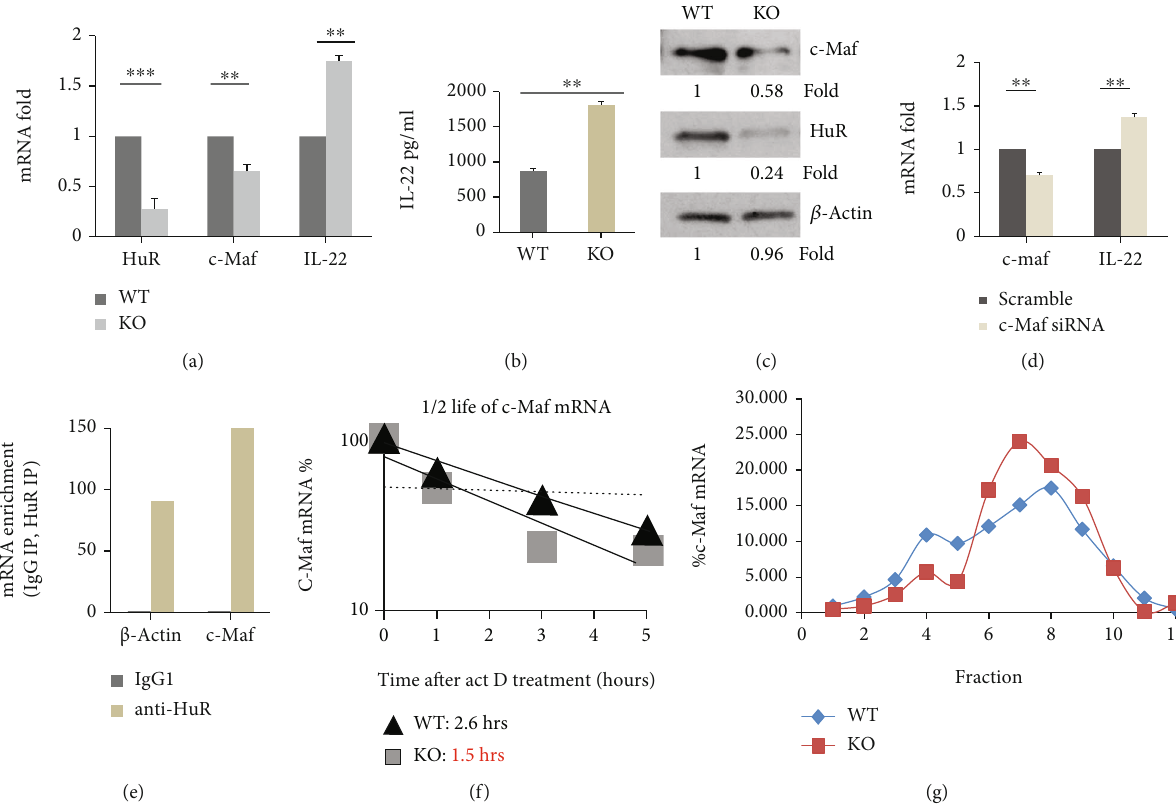
Figure 5: HuR de fi ciency increases IL-22 production in Th17 cells by reducing c-Maf expression. Naïve CD4 + T cells from WT and HuR KO mice were cultured under Th17 cell polarization condition for 5 days. (a) The expression of c-Maf and IL-22 mRNAs was examined by RT- qPCR. IL-22 mRNA RT-qPCR is a positive control in (a). (b) The levels of IL-22 in WT and HuR KO Th17 cell culture supernatant were examined by ELISA. (c) The abundance of c-Maf and HuR protein in WT and HuR KO Th17 cells was examined by western blots. (d) Naive WT CD4 + T cells were transduced with c-Maf siRNA and scramble siRNA and polarized under Th17 cell culture condition for 5 days. The expression of IL-22 and c-Maf mRNA was measured by RT-qPCR assay. (e) HuR bound to c-Maf mRNA as determined by RIP assay; one of the two repeated experiments is shown. The repeated RIP experiment got the same tendency of results. (f) Actinomycin D (3 μ g/ml)-treated Th17 cells were harvested at 1, 3, and 5h; the level of c-Maf mRNA was determined by RT-qPCR assay. One of the two repeated experiments is shown. (g) Polysome fraction assay showed that HuR did not modulate c-Maf mRNA translation. Results in (a) and (b) represent the summary of three independent experiments ( mean ± SEM ). Student ’ s t -test was used for statistics analysis. ∗∗ p < 0 :